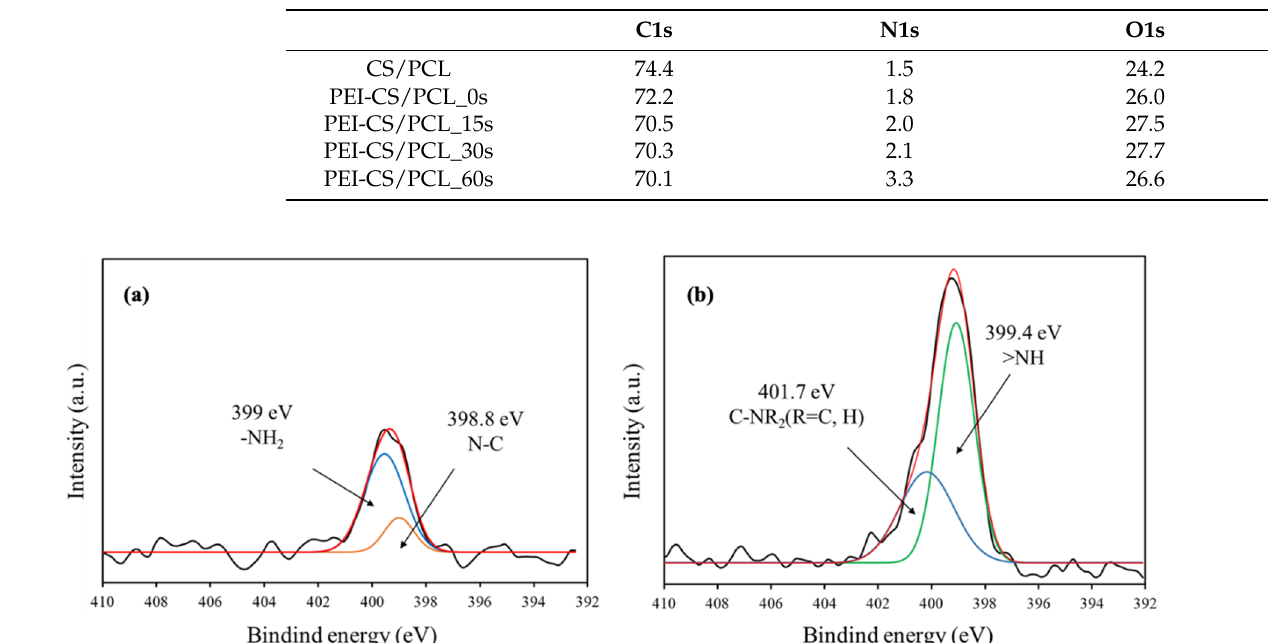
Figure 6. High-resolution N1s peaks of ( a ) CS/PCL, and ( b ) PEI-CS/PCL. Table 1. XPS atomic concentration table for CS/PCL and PEI-CS/PCL.